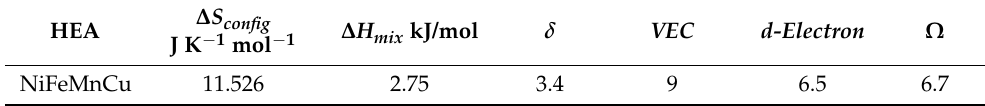
Table 1. Calculated thermodynamic- geometric parameters of HEA